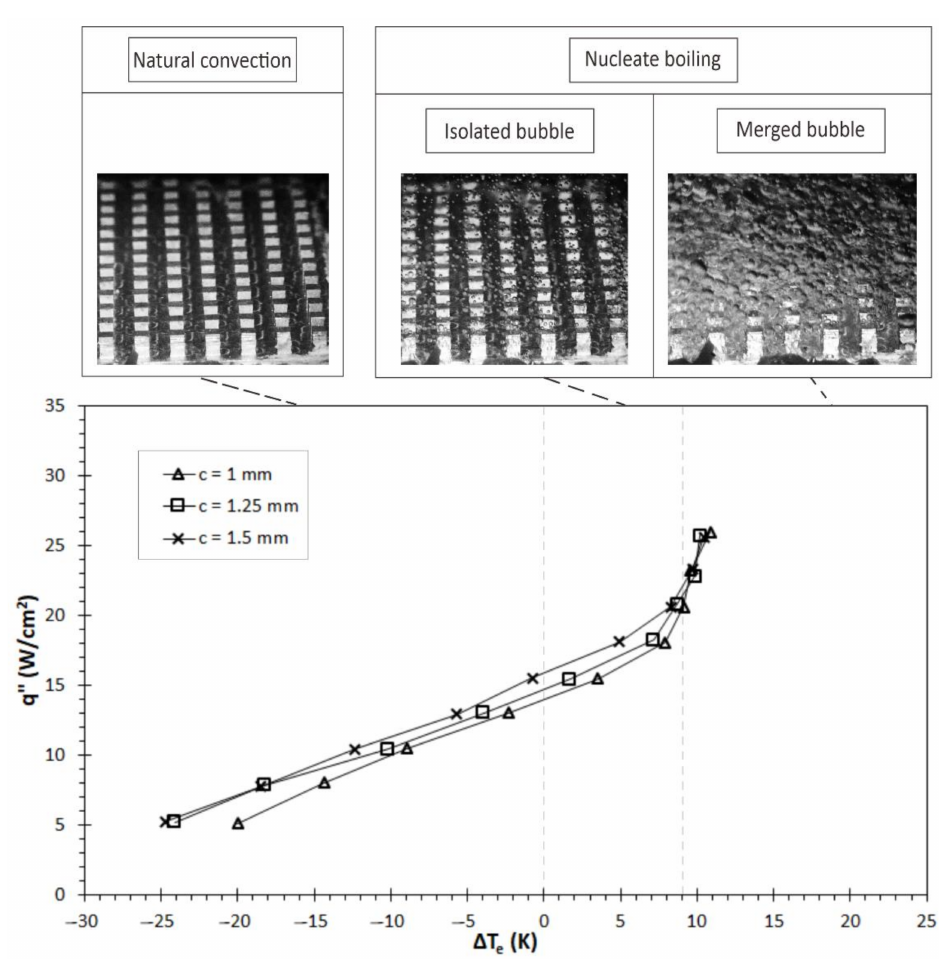
Figure 4. Boiling curve and regime from rectangular pin fin array.